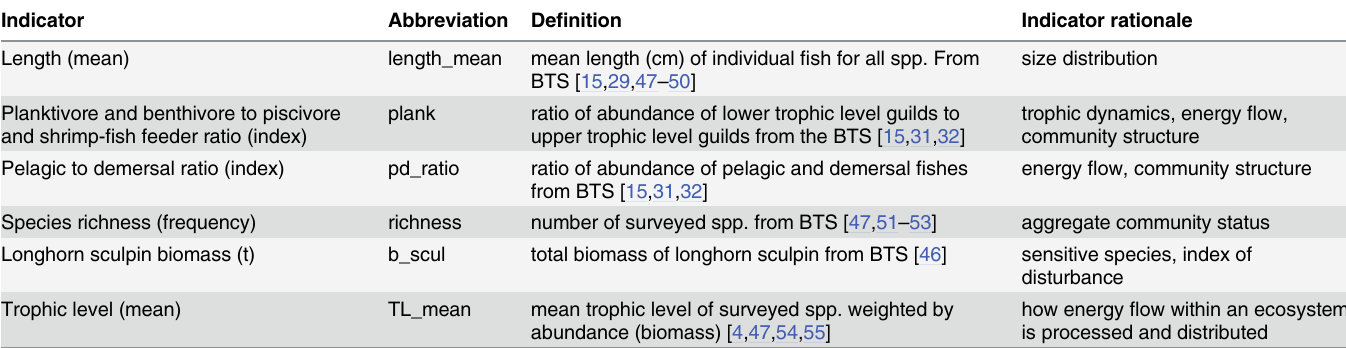
Table 1. Ecological indicators used as response variables in gradient forest